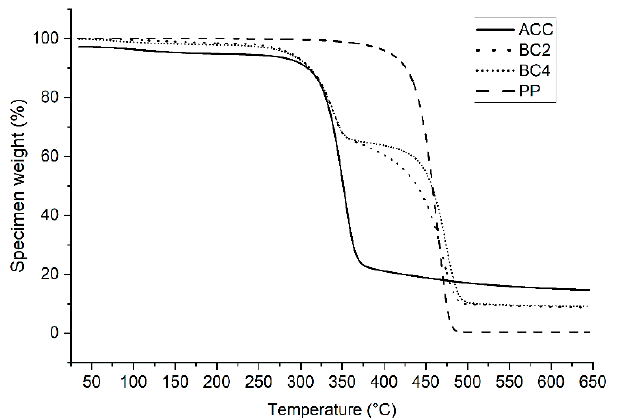
Figure 5. Results of TGA for all-cellulose composites (ACC), polypropylene biocomposites (BC2 and BC4) and neat polypropylene (PP).